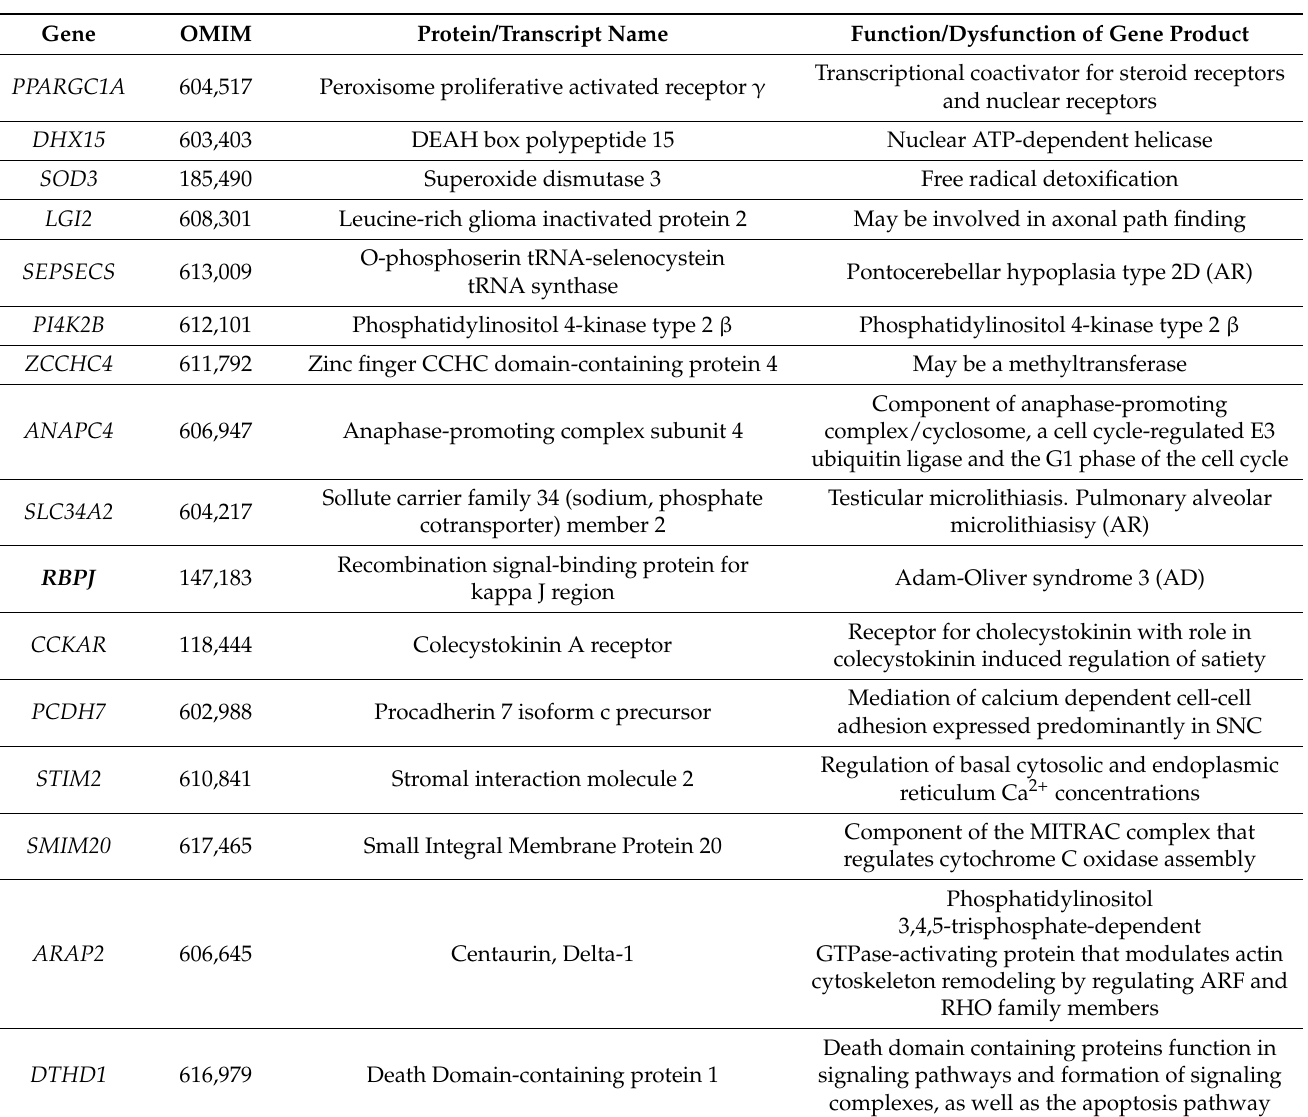
Table 1. Genes deleted in the 4p15.2-14 region in the presented